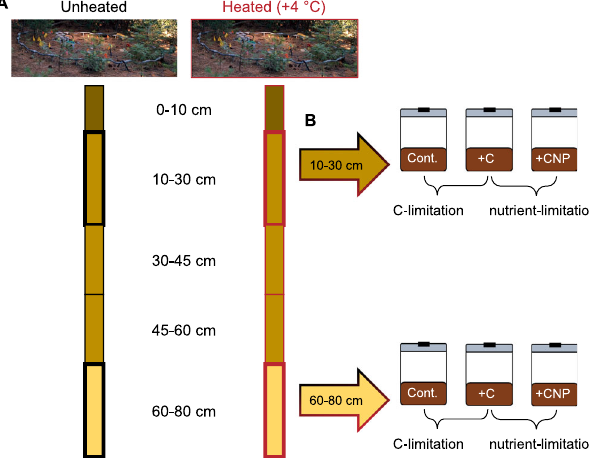
Fig. 1 Field and laboratory experimental design. To test for the effect of warming in the fi eld ( A ), we sampled fi ve soil horizons (0 – 10, 10 – 30, 30 – 45, 45 – 60, and 60 – 80 cm) from unheated and heated ( + 4 °C) plots ( n = 3). The 10 – 30 and 60 – 80 cm horizons from each plot were incubated for 30-d with no amendment (Cont.), cellobiose ( + C), or cellobiose with inorganic nitrogen and phosphorus ( + CNP) to assess the relative resource limitation of each soil ( B ). The response ratio of + C/Cont. and + CNP/ + C was used to determine the relative C- and nutrient limitation,